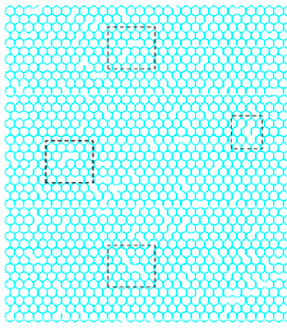
Figure 4. Randomly distributed vacancy in graphene sheet by Monte Carlo simulation.